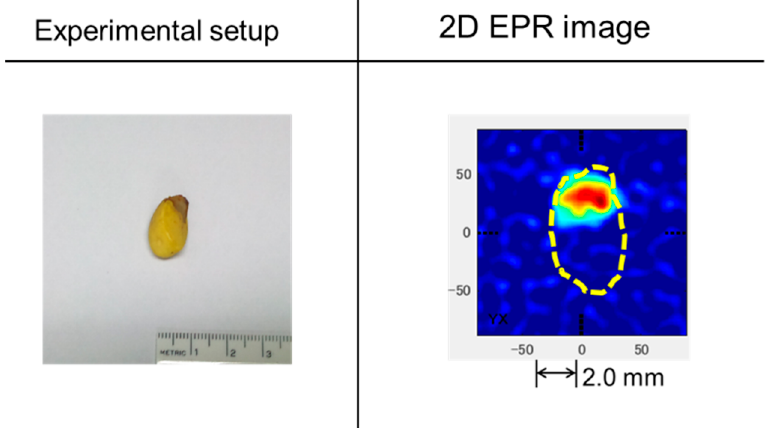
Figure 7. The left-hand panel displays the cotyledon. The right-hand panel displays a 2D EPR image of a C. japonica cotyledon. The dotted line indicates the approximate size of the